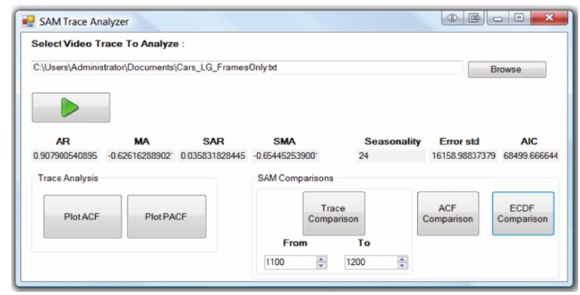
Figure 10: SAM-based video trace analyzer